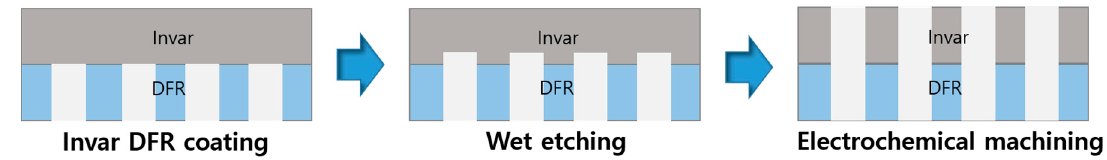
Figure 12. Wet etching and electrochemical fusion machining (photoresist coating face etching).